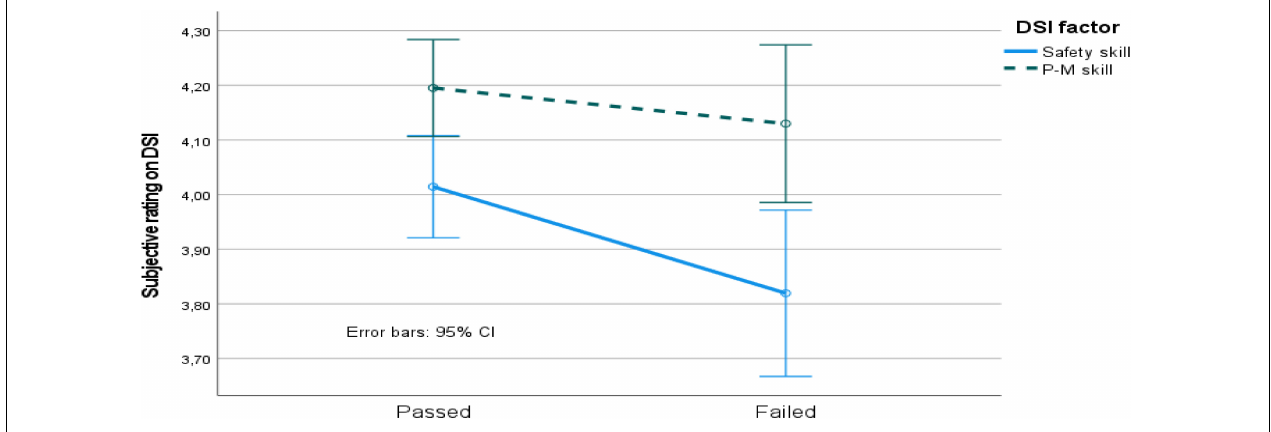
FIGURE 5 | DSI factor values for passed vs. failed driving simulator test participants. P-M skill, perceptual-motor skill; CI, confidence interval.